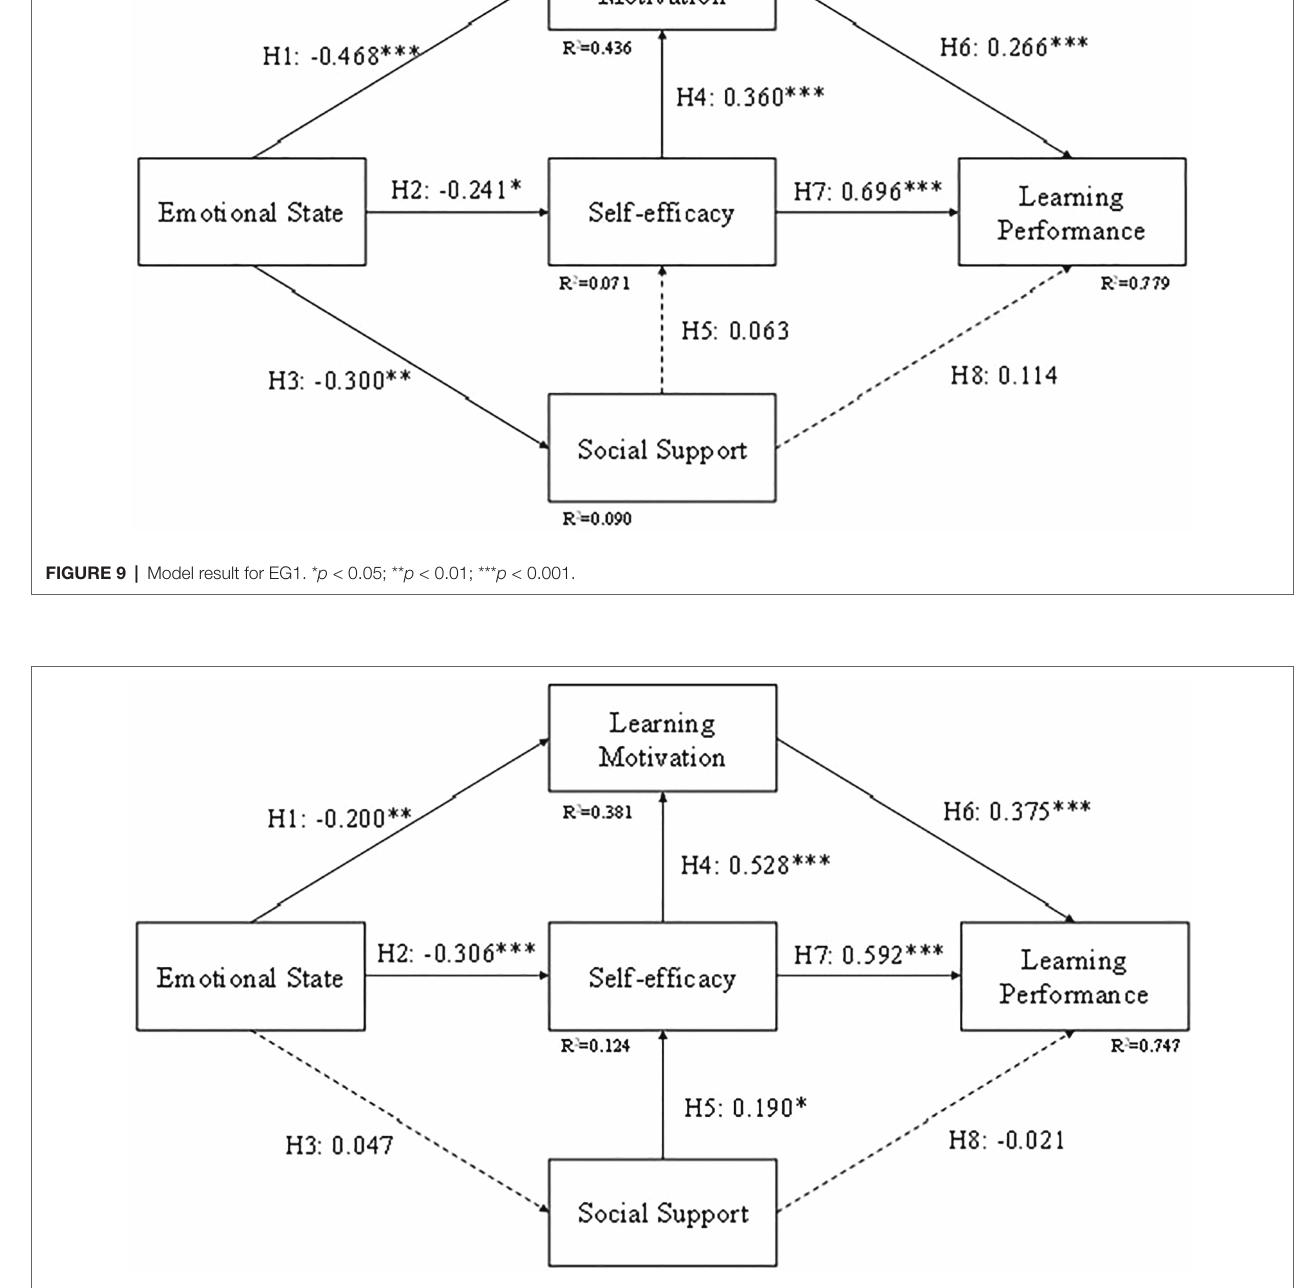
FIGURE 10 | Model result for EG2. * p < 0.05; ** p < 0.01; *** p < 0.001.